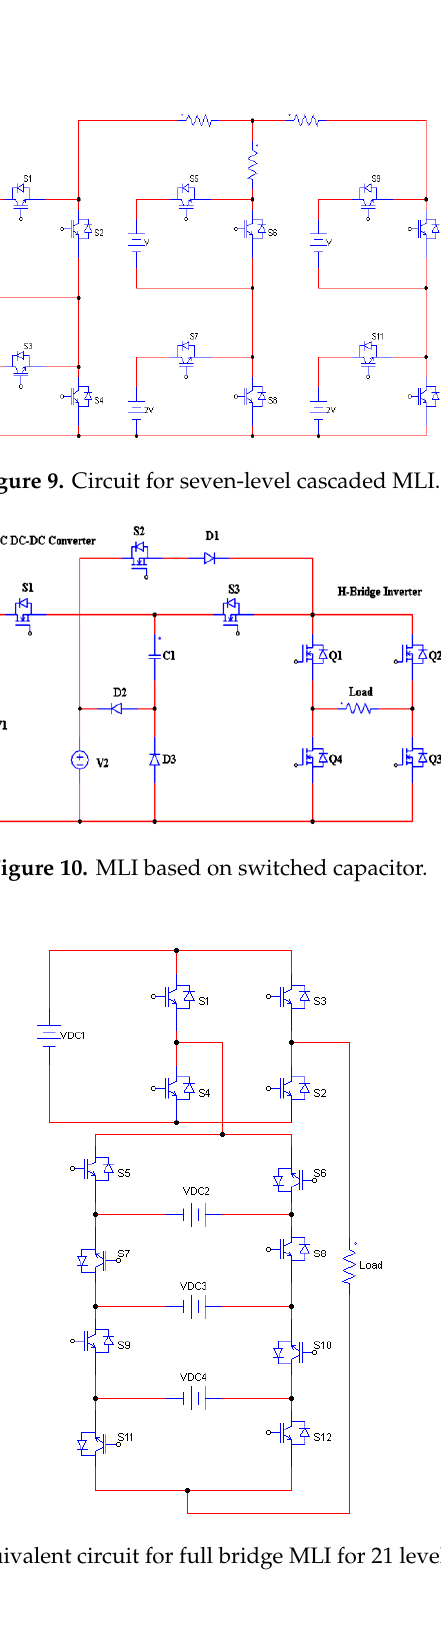
Figure 11. Equivalent circuit for full bridge MLI for 21 levels of output.